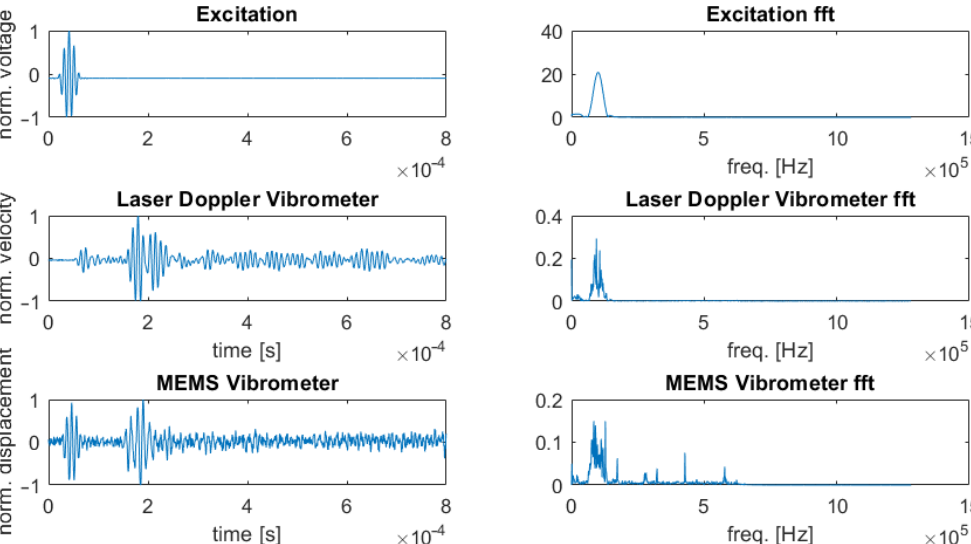
Figure 11. Comparison of signals of GUW in time and frequency domain. Top : Excitation signal (output of function generator). Middle : Signal acquired with the LDV with S 0 wave package at t ≈ 70µs and A 0 wave package at t ≈ 180µs. Bottom : Signal of the MEMS vibrometer with electrical cross-talk at t ≈ 50µs and A 0 wave package at t ≈